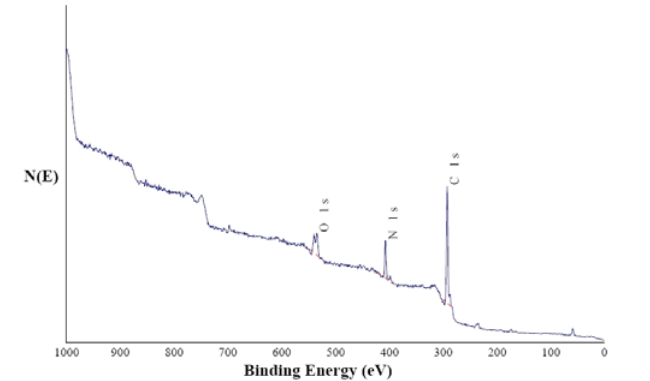
Fig. 2 XPS spectrum of pyrrole treated paper (P= 25 W, T= 10